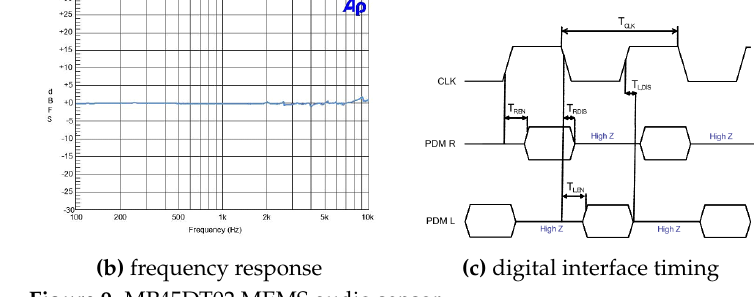
Figure 9. MP45DT02 MEMS audio